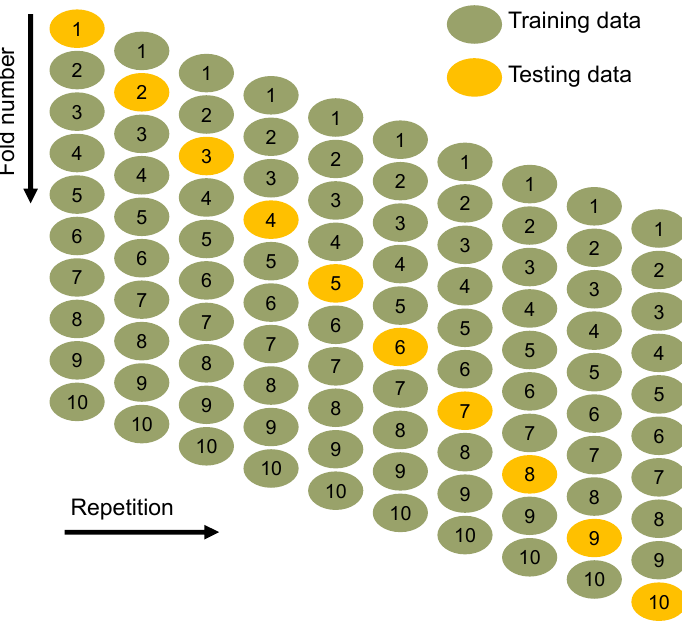
Figure 10. K-fold analysis procedure [50].